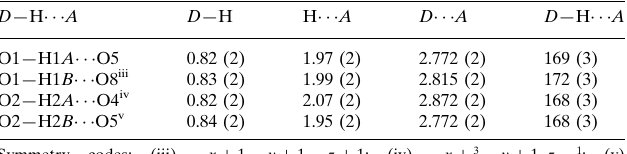
Hydrogen-bond geometry (A˚ , (cid:5)